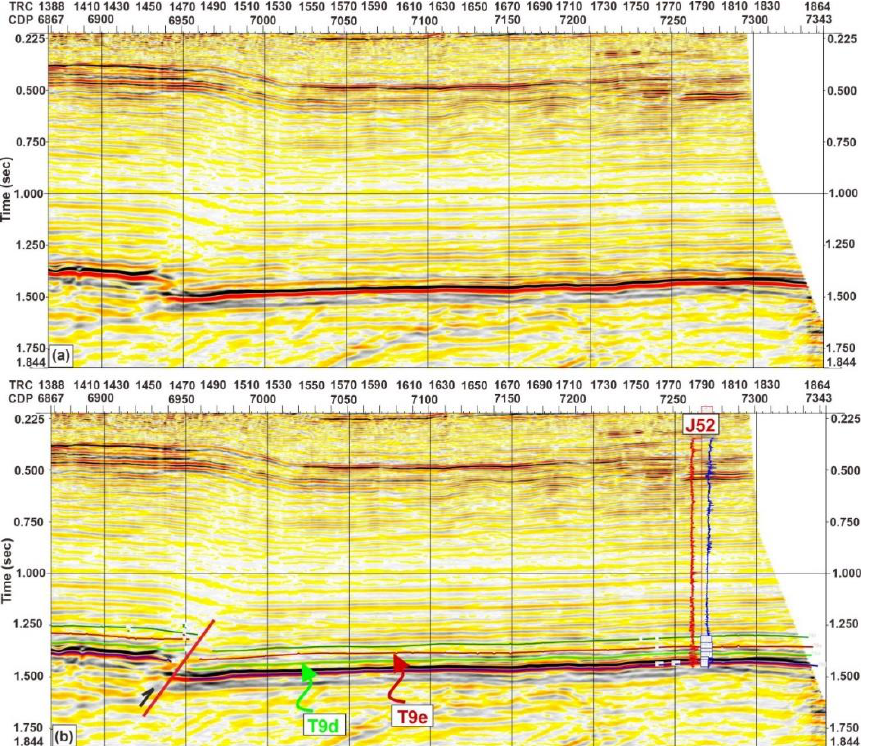
Figure 7. ( a ) uninterpreted, and ( b ) interpreted seismic sections at well J52 with targeted interpreted horizons.